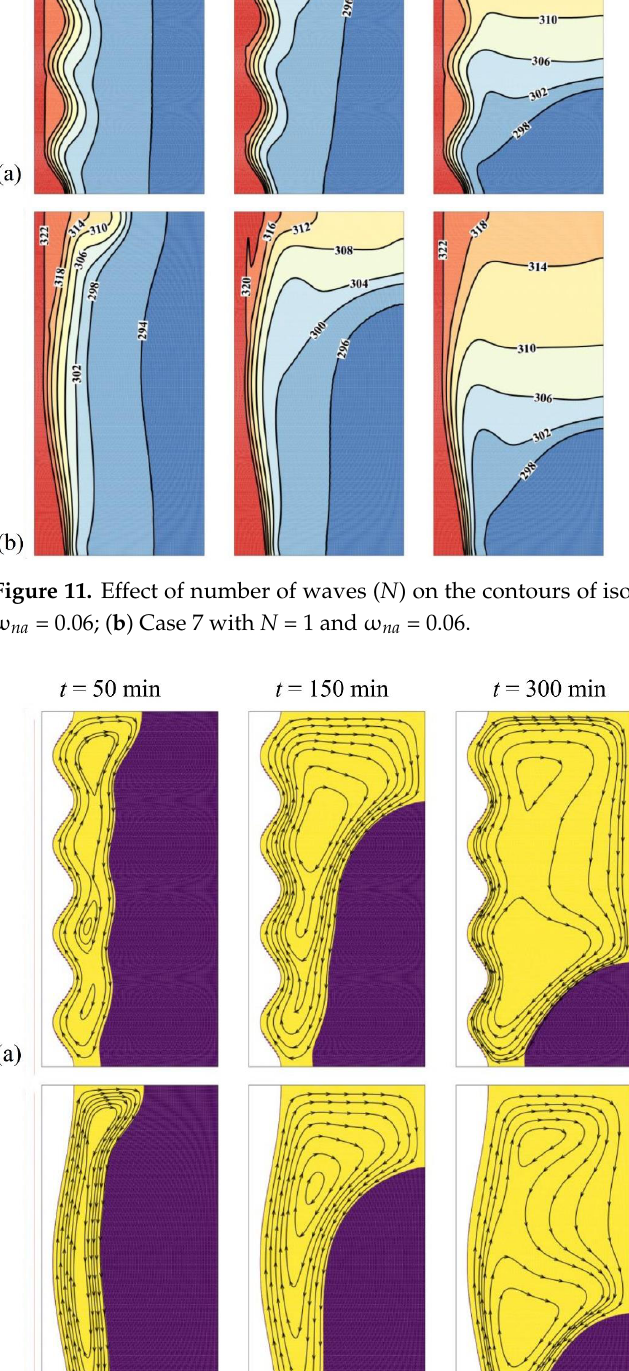
Figure 13. Effect of number of waves ( N ) for ω na = 0.06 and A = 3 mm: ( a ) melting volume fraction; ( b ) total energy storage.